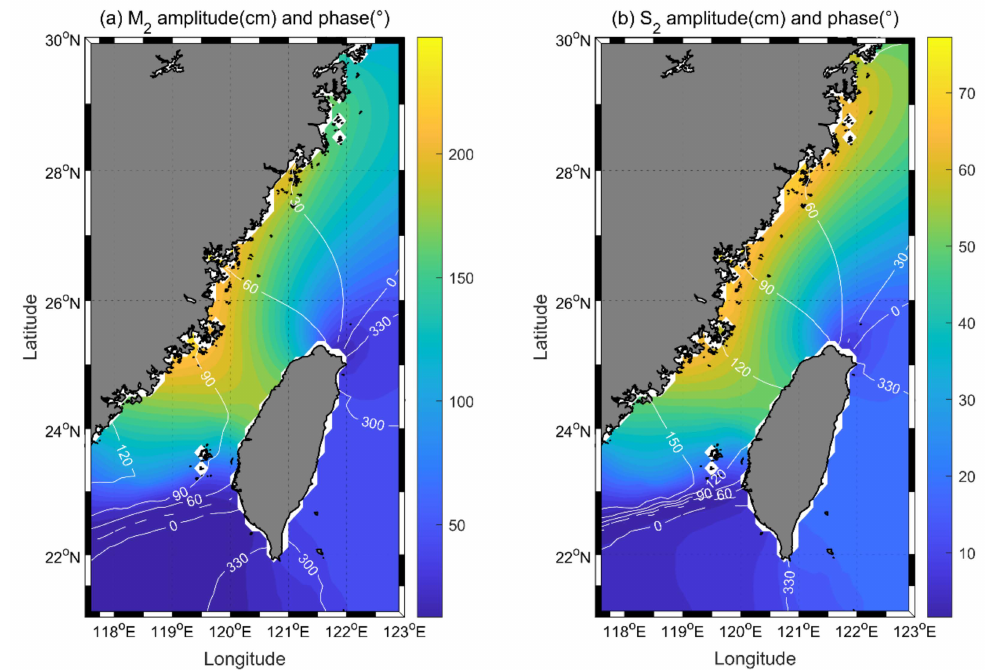
Figure 6. Cotidal charts for M 2 ( a ) and S 2 ( b ) tides in the Taiwan